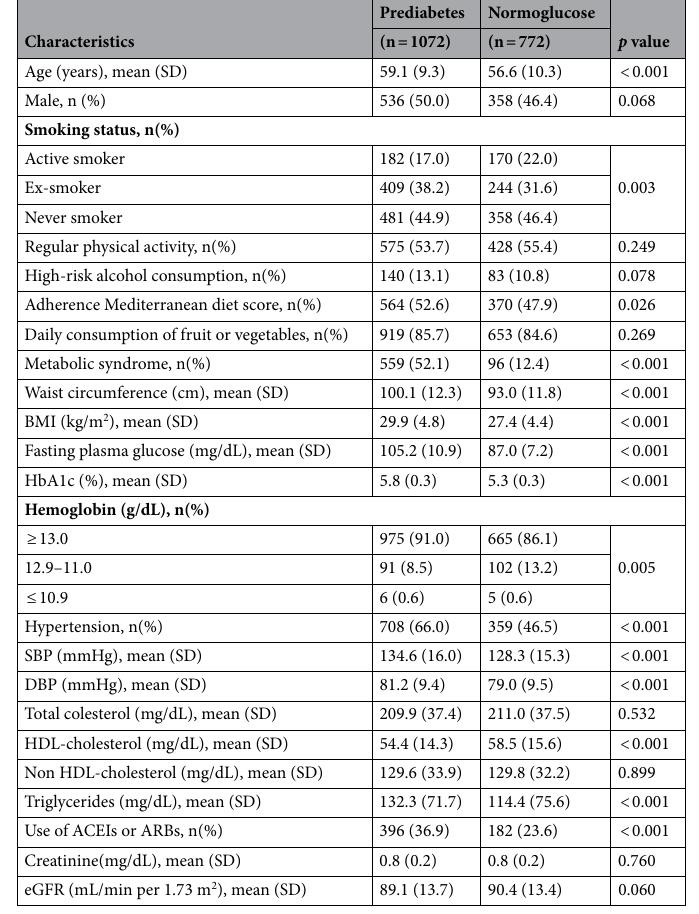
Table 1. Demographic and clinical characteristics of participants at baseline. SBP Systolic blood pressure, DBP Diastolic blood pressure, ACEIs Angiotensin converting enzyme inhibitors, ARBs Angiotensin receptor blockers, eGFR Estimated glomerular filtration rate.